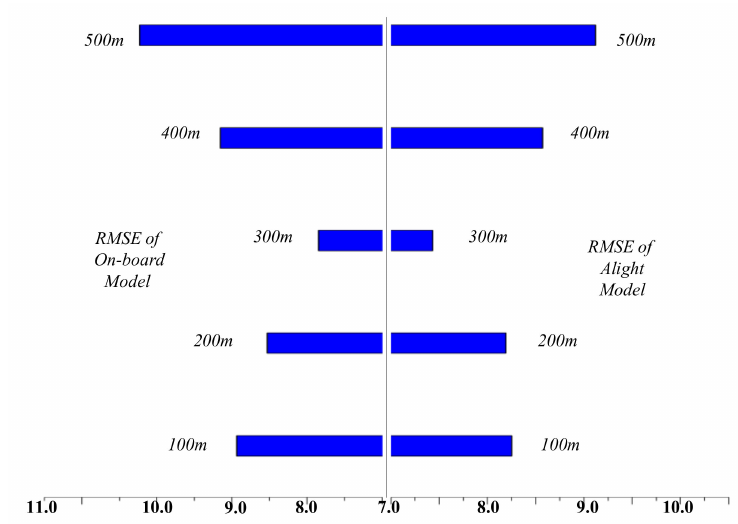
Figure 7. The RMSE and distance of the best service radius configuration part in the HRPFP model for line 56008.